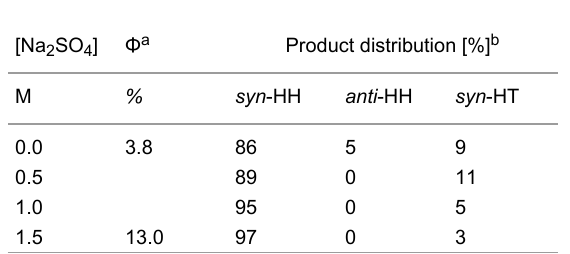
Table 4: Influence of the sodium sulfate concentration on the quantum yield Φ and distribution of photoproducts of COU in a 6.0 mM solution of γ -CD thioether 2